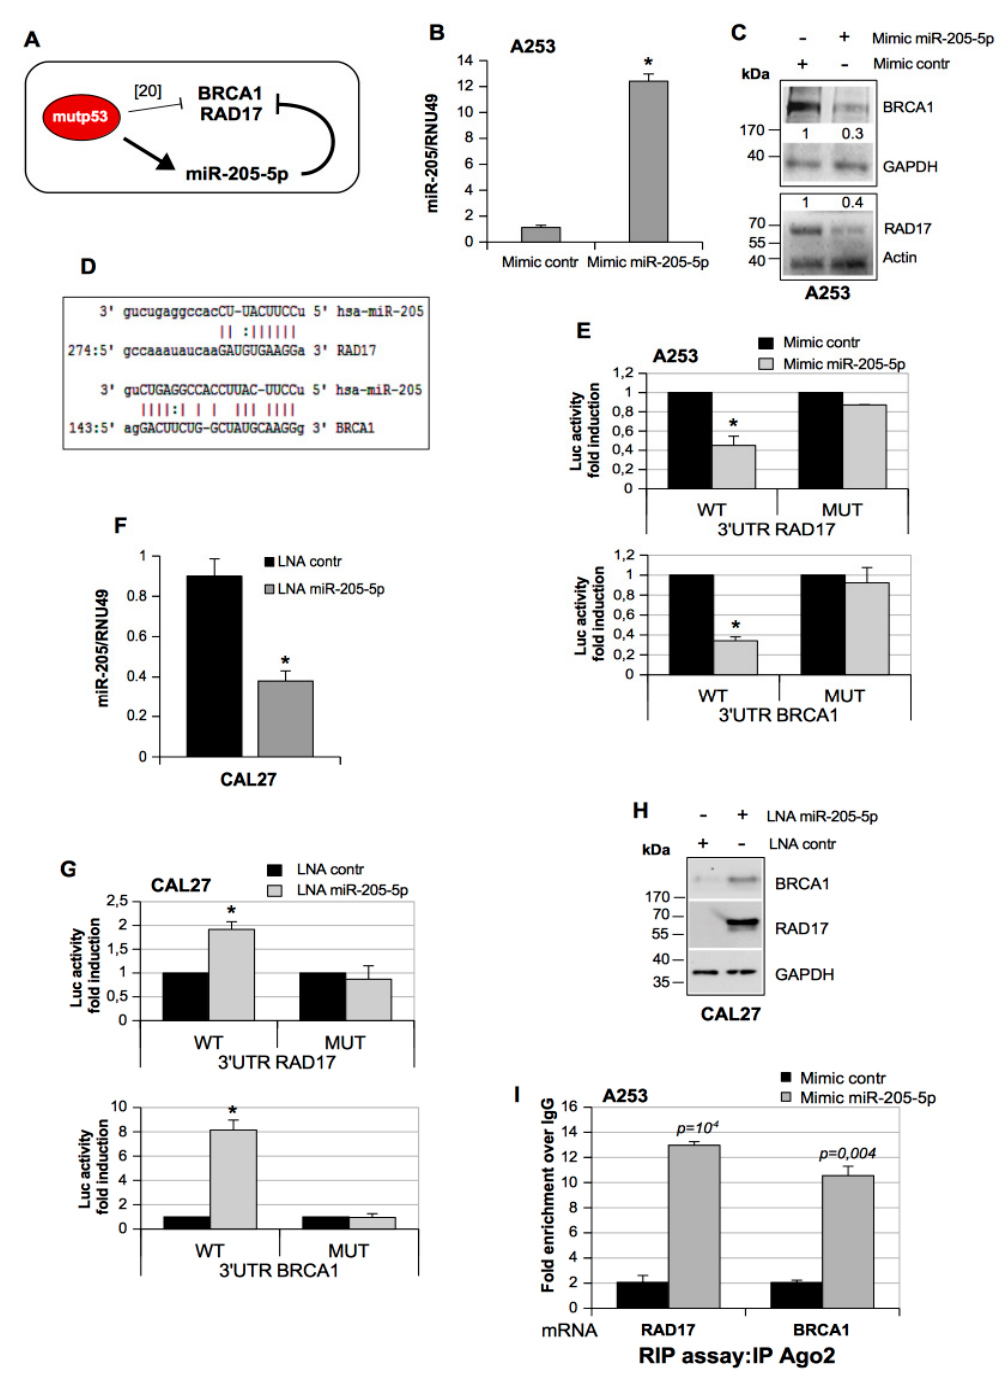
Figure 1. MicroRNA (MiR)-205-5p targets BRCA1 and RAD17 DNA repair genes. ( A ) Schematic model representing the di ff erent levels of BRCA1 and RAD17 gene expression inhibition orchestrated by the mutant p53 protein (mutp53) / miR-205-5p axis. ( B ) A253 cells transfected with mimic control and mimic miR-205-5p oligos are analyzed for miR-205-5p expression using a Taq-Man assay. The RNA levels were normalized versus RNU49 . Bars represent the mean ± SD from three biological replicates. The p -values were calculated using a two-tailed t -test. * p < 0.05. ( C ) Representative Western blotting of BRCA1, RAD17, and GAPDH (loading control) protein expression in A253 cells treated as described in (B). ( D ) Representation of the pairing between miR-205-5p and the 3’ UTR (untraslated region) of its putative messenger RNA (mRNA) targets, BRCA1 and RAD17 mRNAs. ( E ) Activity for RAD17 3’ UTR and BRCA1 3’ UTR luciferase reporter vectors and mutated RAD17 3’ UTR and BRCA1 3’ UTR were determined after 48 h of transfection with mimic control and mimic miR-205-5p oligos in A253